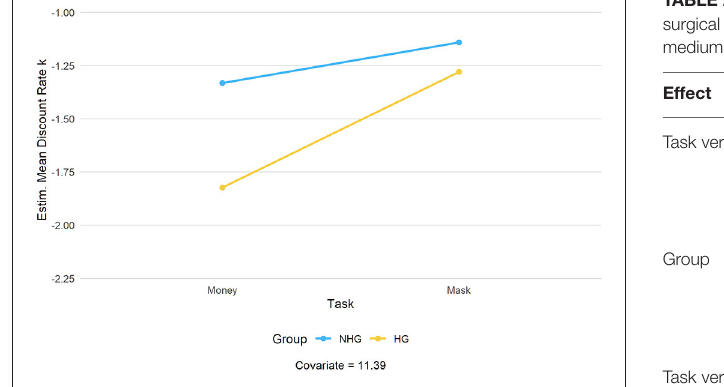
FIGURE 1 | Estimated mean discount rate across task versions (money vs. surgical mask) and hoarding group (HG vs. NHG).